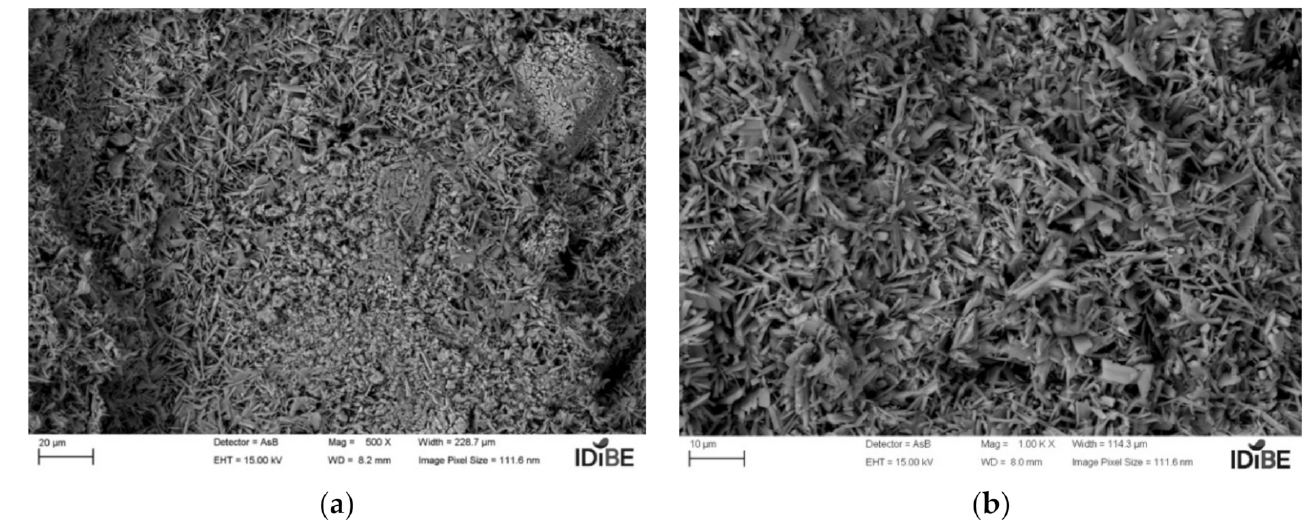
Figure 2. Non-additive calcium sulfate micrograph: ( a ) 20 µ m; ( b ) 10 µ m (source: the author). The setting speed of 1.35 min implied a matrix of small and compact crystals.